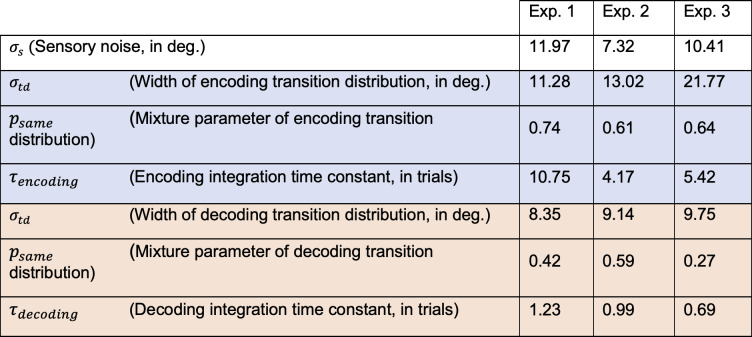
Best fitting parameters of the observer model with efficient encoding and history-dependent Bayesian decoding (Full efficient-encoding-Bayesian-decoding model).Parameters of the encoding and decoding stages are presented in the blue and red shaded cells, respectively. Note that exponential integration time constants are fitted in units of trials, and can be converted into an estimate of seconds by multiplying with the average trial duration of the respective experiment (average trial durations: Exp. 1: 5.38 s; Exp. 2: 6.55 s; Exp. 3: 8.25 s).